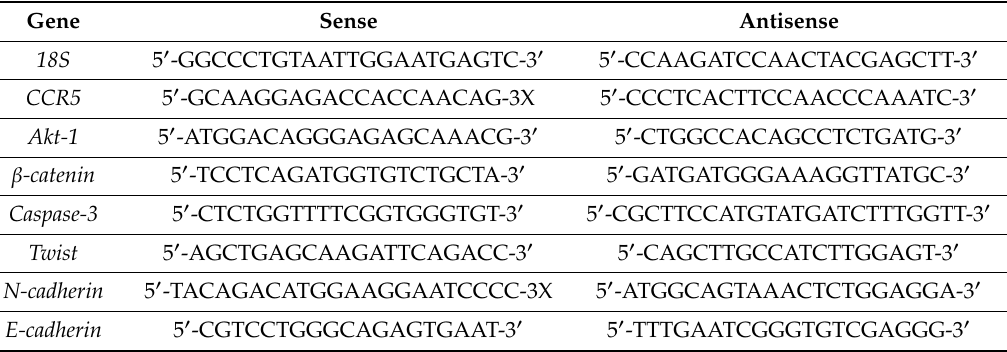
Table 1. Primer sequences used for